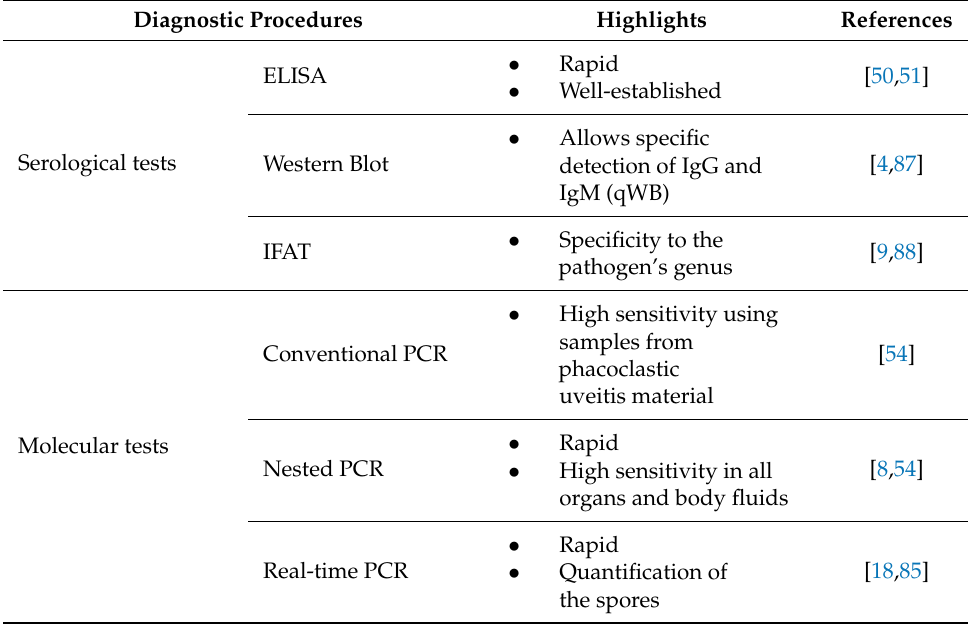
Table 1. Summary table of E. cuniculi diagnostic